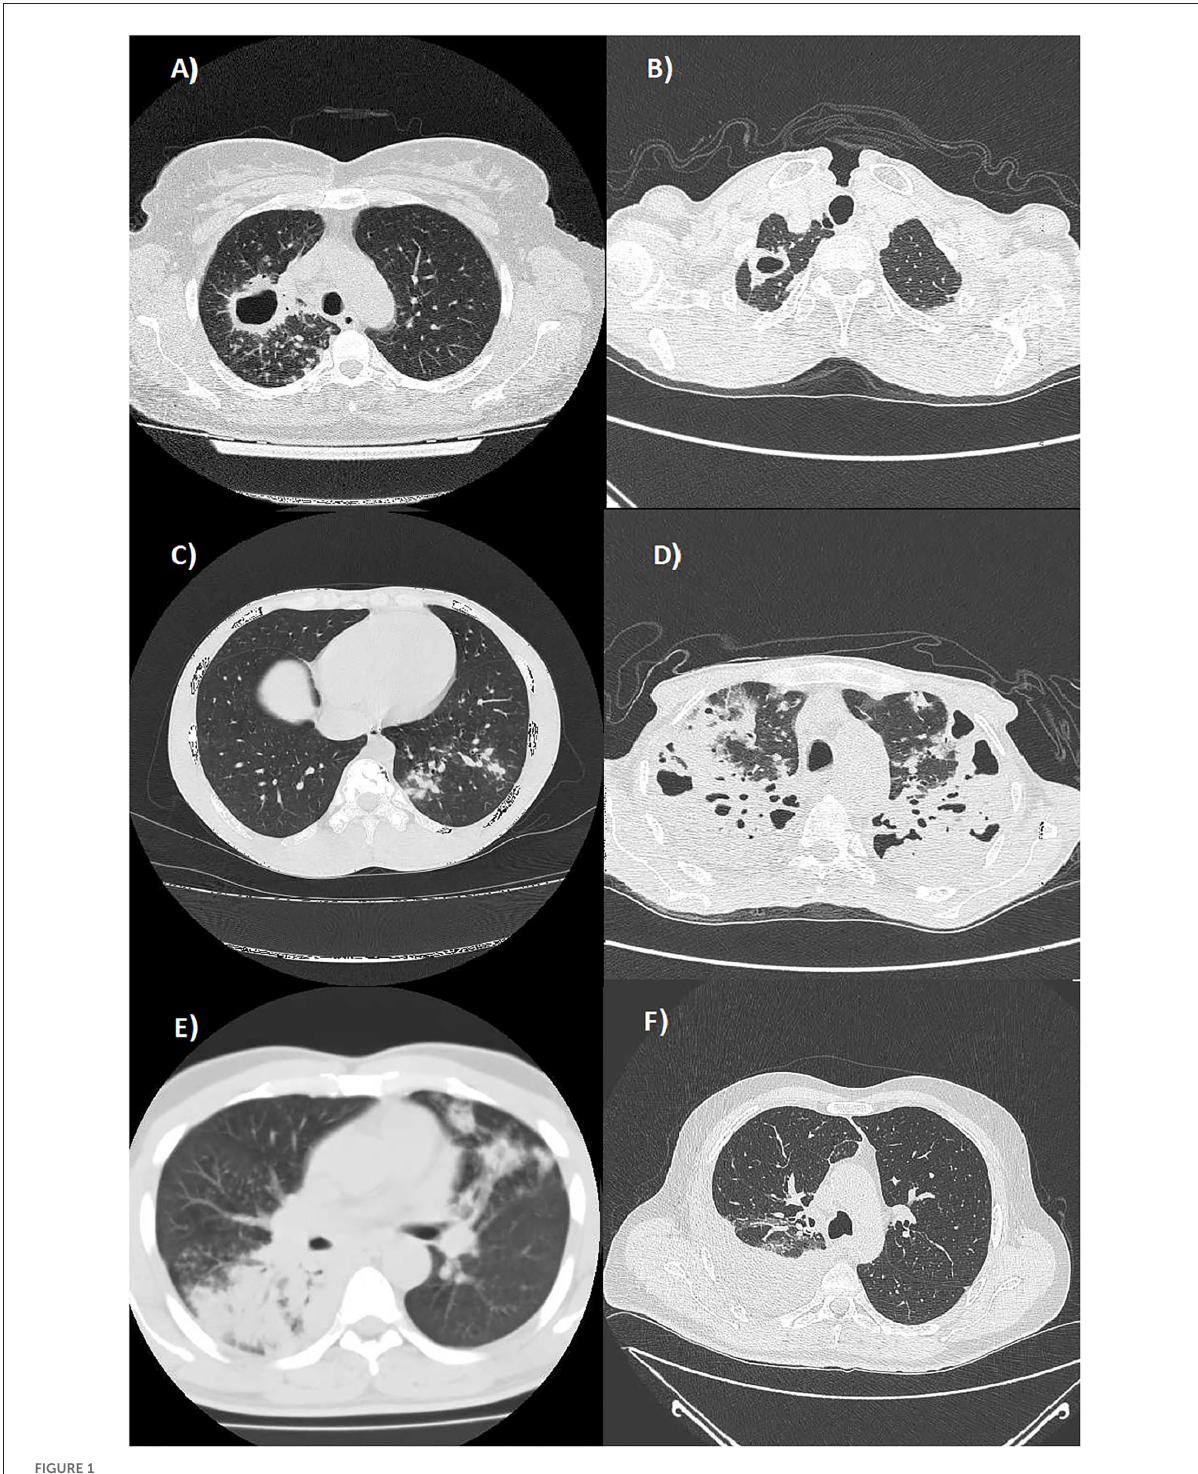
FIGURE1 Axial Chest CT scans (lung window) showing: (A) multiple well-defined nodules diffusely distributed in the upper lobes and a cavitated lesion with thickened walls in the posterior segment of the right upper lobe (productive form with typical location); (B) a cavitated lesion with thickened walls in the apical segment of the right upper lobe (productive form with typical location); (C) a nodular pattern in the posterior segment of the left lower lobe (productive form with typical location); (D) a multifocal bilateral tubercular pneumonia in the upper lobes (exudative form with atypical locations); (E) multifocal tubercular pneumonia affecting the superior segment of the right lower lobe and the lingula (exudative form with atypical locations); and (F) a right tuberculous pleural effusion (exudative form with atypical